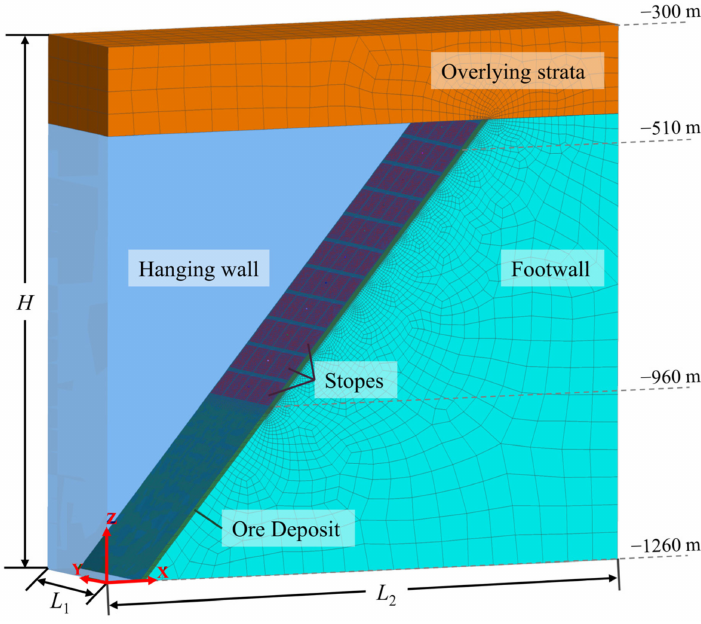
Figure 2. The simulation model of backfilled